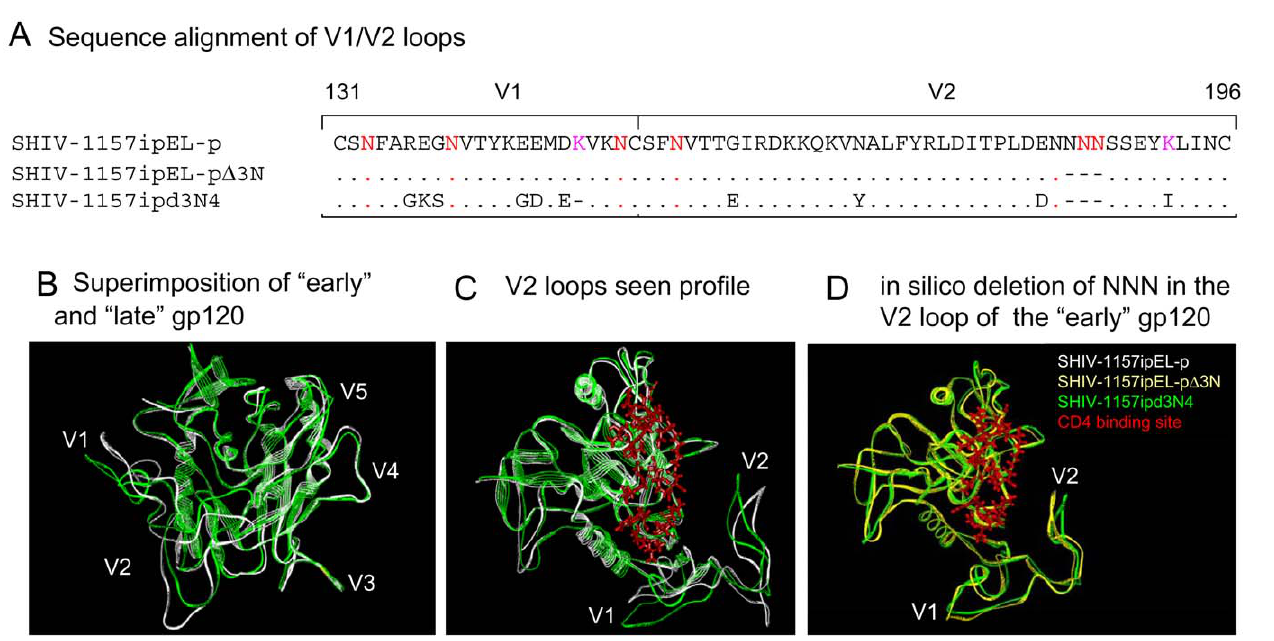
Figure 5. (A) Sequence alignment of V1/V2 sites of and SHIV-1157ipEL-p, SHIV-1157ipEL-p D 3N and SHIV-1157ipd3N4 (numbering according to HXB2). (B) Molecular modeling of SHIV-1157ipEL-p and SHIV-1157ipd3N4 sequences was performed using the X-ray structure of the CD4-bound YU2 gp120 core [20]; PDB code 1RZK). The V1, V2, and V3 loops were modeled onto the core. Mutations inducing structural heterogeneity in the V1 and V2 loops were identified. (C and D) Illustration of three-dimensional (3D) gp120 of SHIV-1157ipEL-p (white), SHIV-1157ipd3N4 (green), and (D) SHIV- 1157ipEL-p D 3N (yellow) showing that access to the CD4 binding site (red) is more restricted for SHIV-1157ipEL-p D 3N and SHIV-1157ipd3N4 than for SHIV-1157ipEL-p. doi:10.1371/journal.pone.0011689.g005 PLoS ONE |